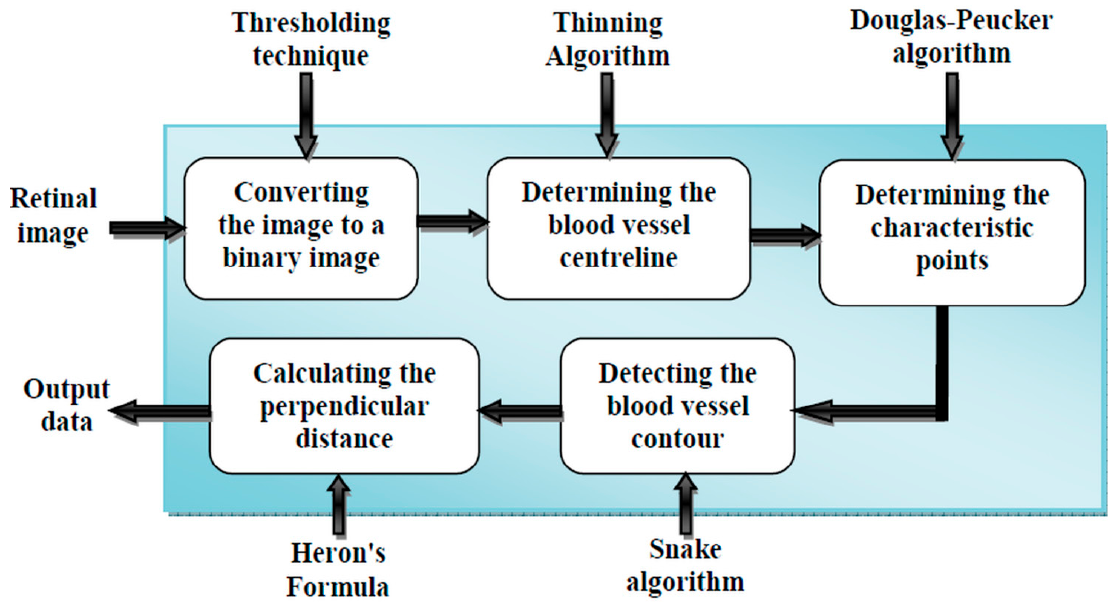
Figure 1. Block diagram of the proposed method.